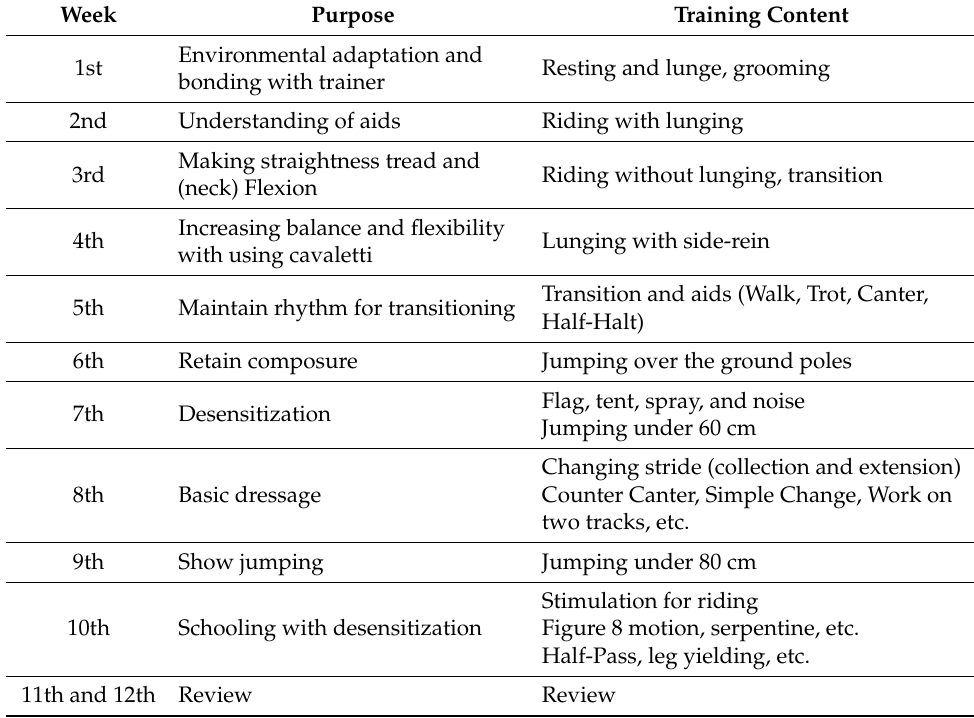
Table 1. Training goals for each week.